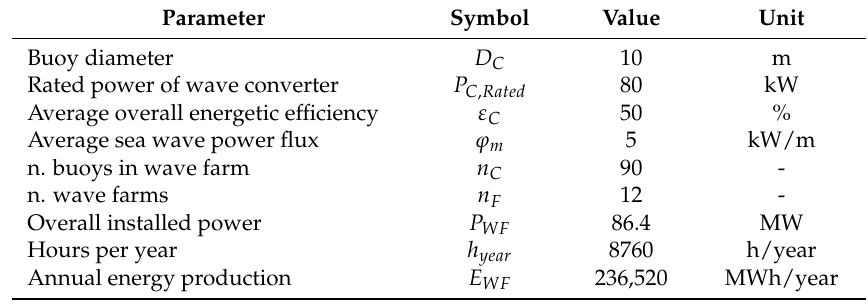
Table 1. Wave farm parameters.